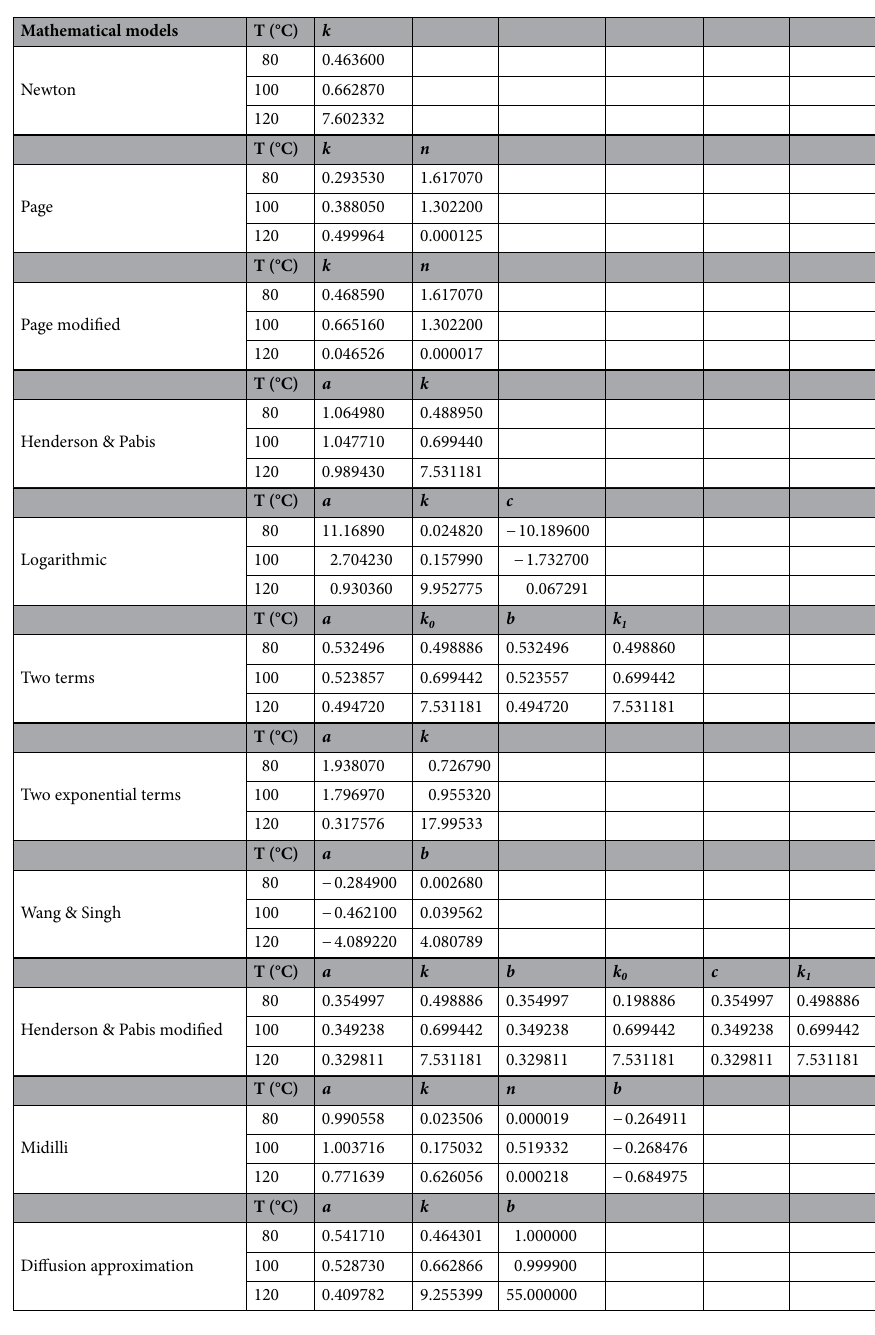
Table 1. Parameters obtained from models fitted to the data for drying of soybean grains for 23% (d.b.) of initial moisture